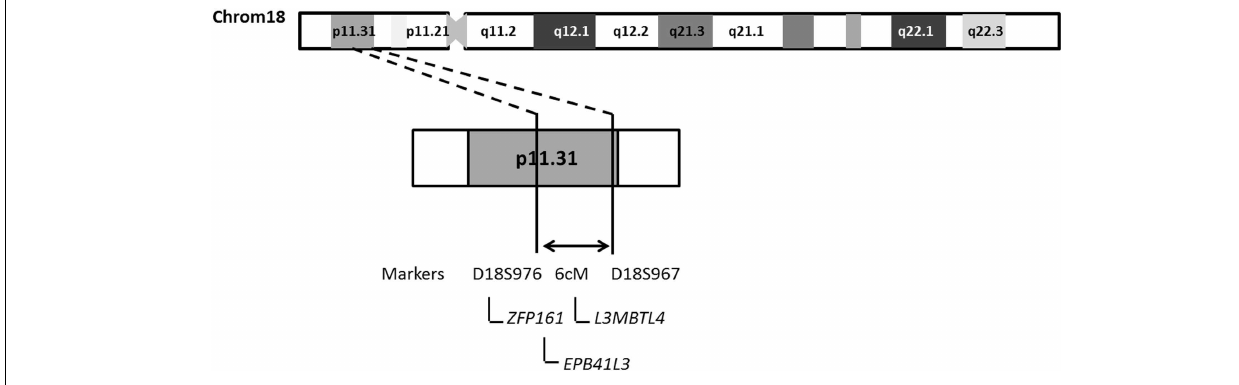
D18S 967. A search in the NCBI 3 and Ensembl database 4